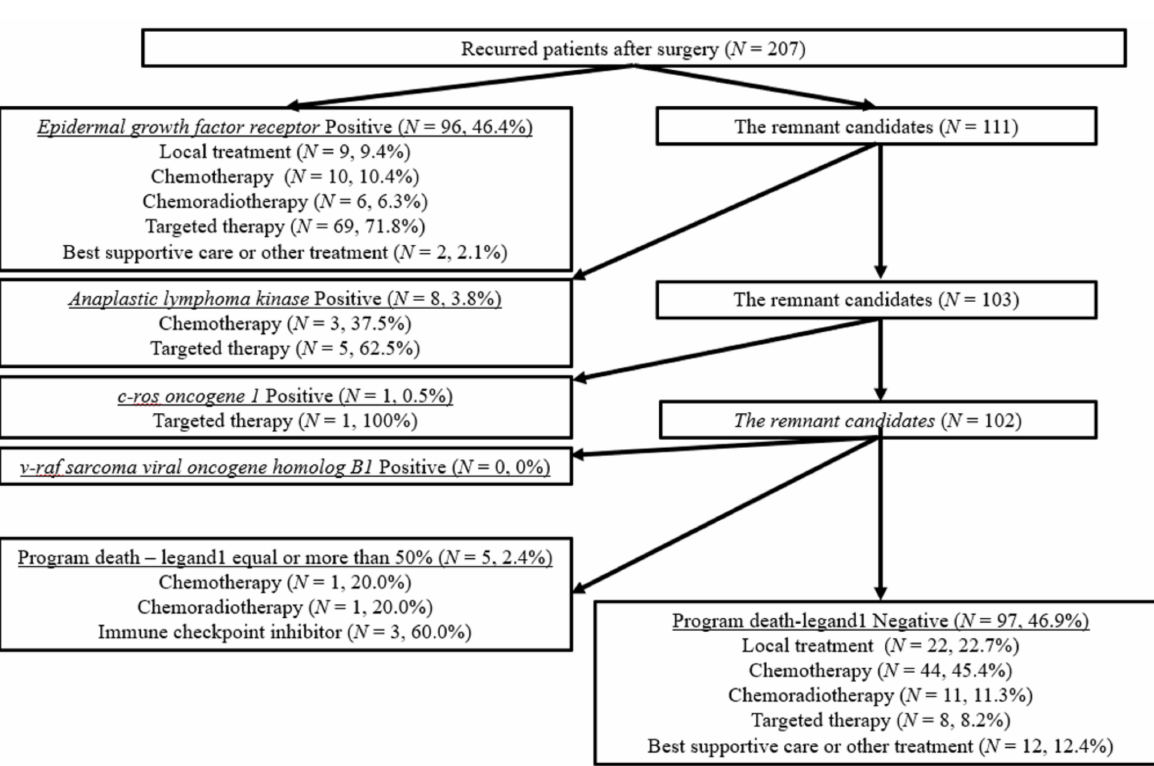
Figure A1. Patient flow diagram after recurrence according to the mutational information and program death—ligand 1